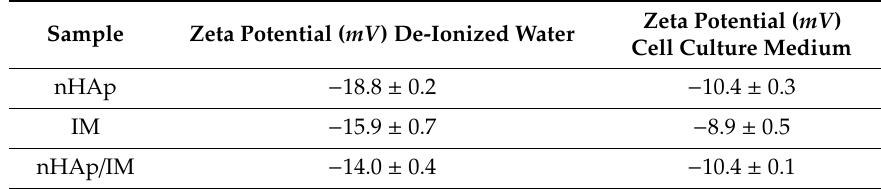
Table 2. Zeta potentials of nanohydroxyapatite (nHAp), Imatinib mesylate (IM), and nHAp modified by IM in de-ionized water and culture